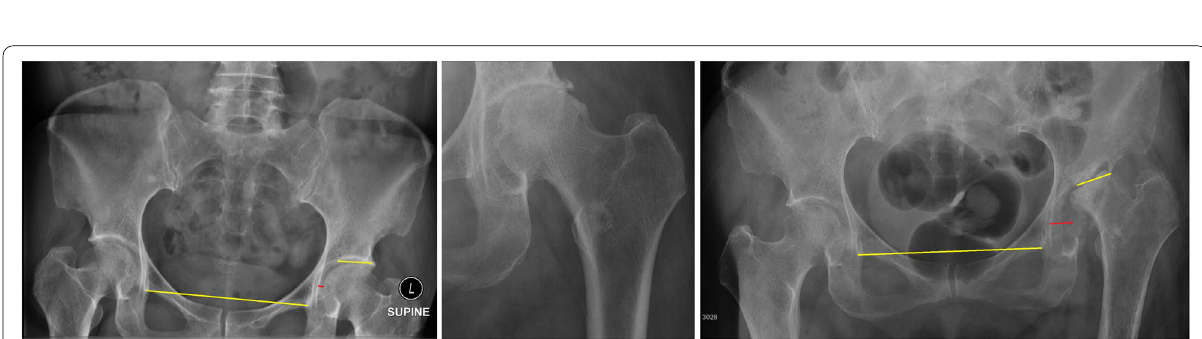
Fig. 2 Measuring the changes of Tonnis angle and lateral subluxation. The Tonnis angle and lateral subluxation progressed within 9 months with radiological progression from normal (left) to type 1 (middle) and type 2 (right) RPOA. The Tonnis angle increased from 5 to 11 degrees, and lateral subluxation from 5 to 17